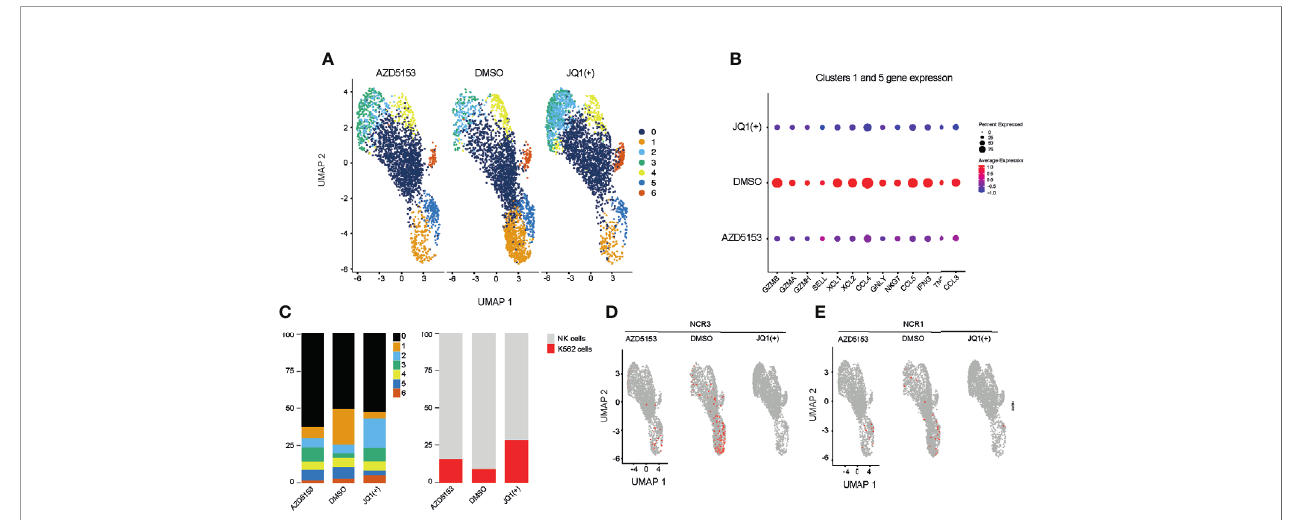
FIGURE 7 | Single-cell transcriptomics reveals a heterogeneous response to BET bromodomain inhibition. NK cells were stimulated with IL-15 (10ng/mL) and treated with DMSO, JQ1(+) or AZD5153 for 24 h. NK cells were then co-cultured with K562 cells for 2 h and single-cell RNA sequencing was performed. (A) A Uniform Manifold Approximation and Projection (UMAP) plot showing clustering and differences between DMSO, JQ1(+) and AZD5153 treated NK cells in co-culture with K562 cells (B) The average gene expression in highly in fl ammatory NK clusters 1 and 5 between DMSO, JQ1(+) and AZD5153 treated NK cells. (C) Bar charts showing the relative proportion for each cluster in all treatment groups. The right bar chart shows the relative cell proportions of NK cells to K562 cells. (D) UMAP plots showing the expression of NCR3 between DMSO, JQ1(+) and AZD5153 treated NK cells. (E) UMAP plots showing the expression of NCR1 between DMSO, JQ1(+), and AZD5153 treated NK cells.